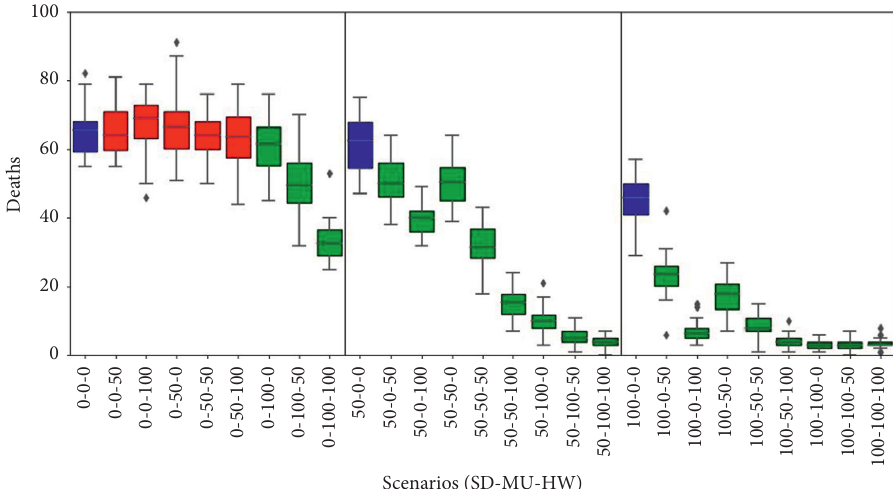
Figure 4: Mortality results. Box plots represent average and standard deviation of the cumulative count of deaths in each scenario. Scenarios are labelled according to the willingness of agents to adhere to personal health habits such as social distance, mask user, or hands washer (SD %, MU%, and HW%). Baseline scenarios were defined varying the proportion of social distancers in the population assuming no agents adopt using masks or washing hands. In each panel, the baseline scenario is coloured blue (left, 0%-0%-0%; middle, 50%-0%-0%; right, 100%-0%-0%). Scenarios with statistical significant difference compared to their corresponding panel baseline (blue) are coloured green ( p value < 0 : 05); otherwise, they are coloured red.